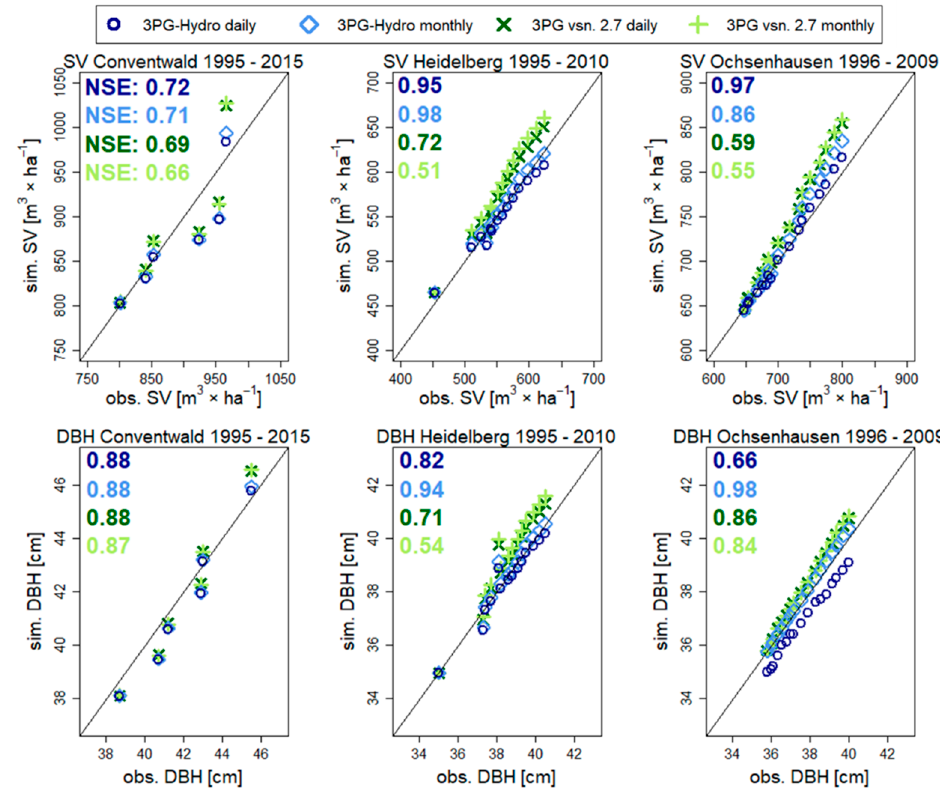
Figure 2. Validation of forest ‐ growth prediction (stand volume (SV) and mean diameter at breast height (DBH)) for all stands over observed periods: plotting simulated data (sim.) against observed data (obs.). Numbers of observations at Conventwald, N = 6; Heidelberg, N = 15; Ochsenhausen, N = 17. Colors of NSE indicating each simulation model as in legend assigned.